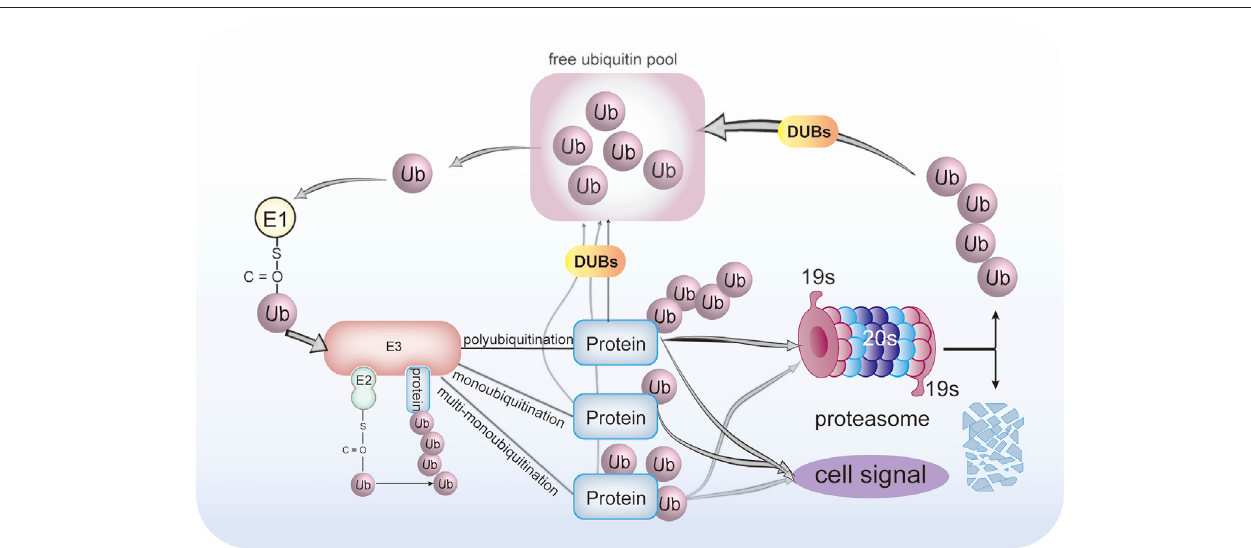
FIGURE 1| Protein ubiquitination and deubiquitination process. Ubiquitin wasactivated by E1 ubiquitin-activating enzyme in an ATP-dependent manner to form a thioesterbondbetweentheactive-sitecysteinesulfhydrylgroupoftheE1enzymeandtheC-terminalglycineofubiquitin.Then,activatedubiquitinistransferredontothe catalytic cysteineresidueE2ubiquitin-conjugatingenzymeinthepresenceofATP,whichdeterminesthetypeofsubstrateubiquitination.Finally,undercoordinationbya speci fi cE3ligasethatdeterminessubstratespeci fi city,ubiquitiniscovalentlyboundtoasubstrate.Theproteinscanbeconjugatedwitheithermonoubiquitin,multi- monoubiquitin, or polyubiquitination. The DUBs can reverse this process. The ubiquitinated proteins can either be degraded by the 26S proteasome or transduced cell signal. The DUBs can remove and recycle the ubiquitin chains to regenerate free